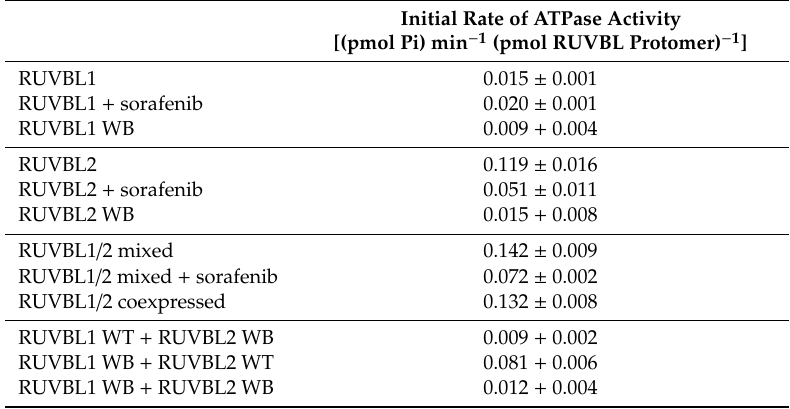
Table 1. Initial rates for the ATPase activity of di ff erent RUVBL